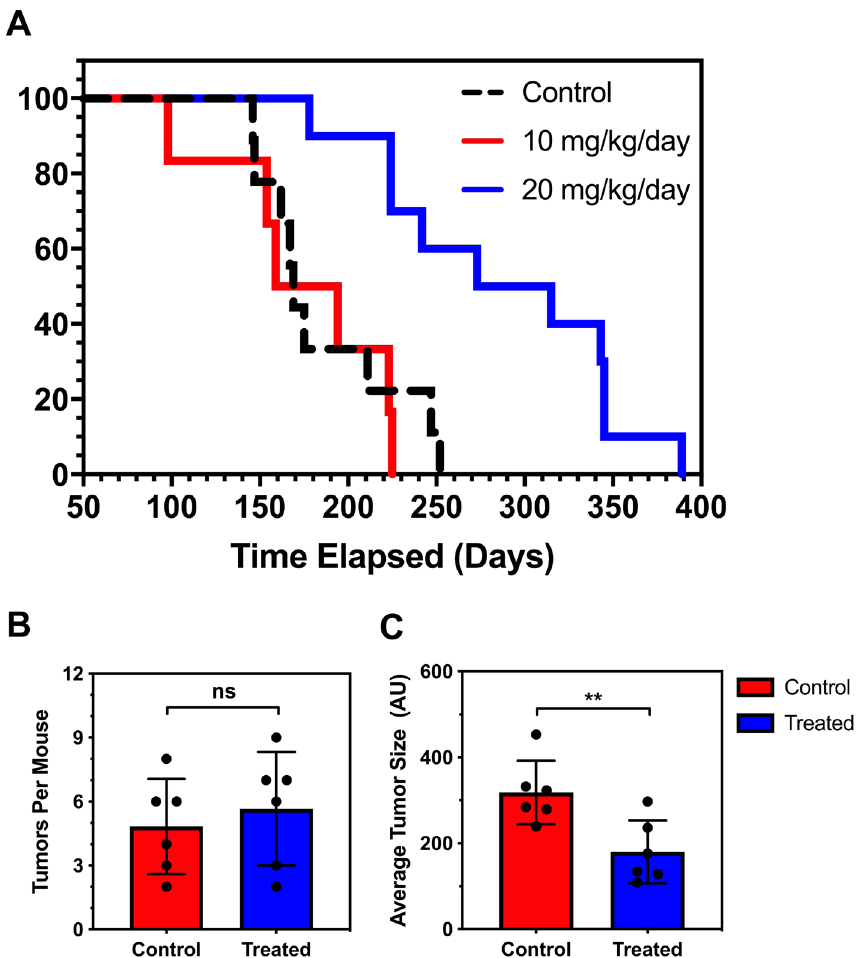
Figure 2. ( A ) Kaplan–Meier analysis of APC Min/+ mouse survival (Study A). The majority of APC Min/+ untreated mice (N = 11) die before 170 days of life, consistent with prior reports 30 . Oral MTDIA dosing at 10 mg/kg/day (N = 10) showed no significant effect on mouse survival. Oral MTDIA dosing at 20 mg/kg/day (N = 10) showed an approximate doubling in lifespan for APC Min/+ mice. ( B,C ) Histolopathologic assessment of APC Min/+ mouse intestinal tissue. The mean number of tumors ( B ) and average size ( C ) of intestinal adenomas was compared in control (N = 6) and 20 mg/kg/day treated (N = 6) mice. The change in the number of tumors per mouse following treatment was not statistically significant. The average tumor size for treatment mice was decreased by 43% in mice treated with 20 mg/kg/day MTDIA ( p = 0.0086). Tumor size was measured in “AU” or arbitrary